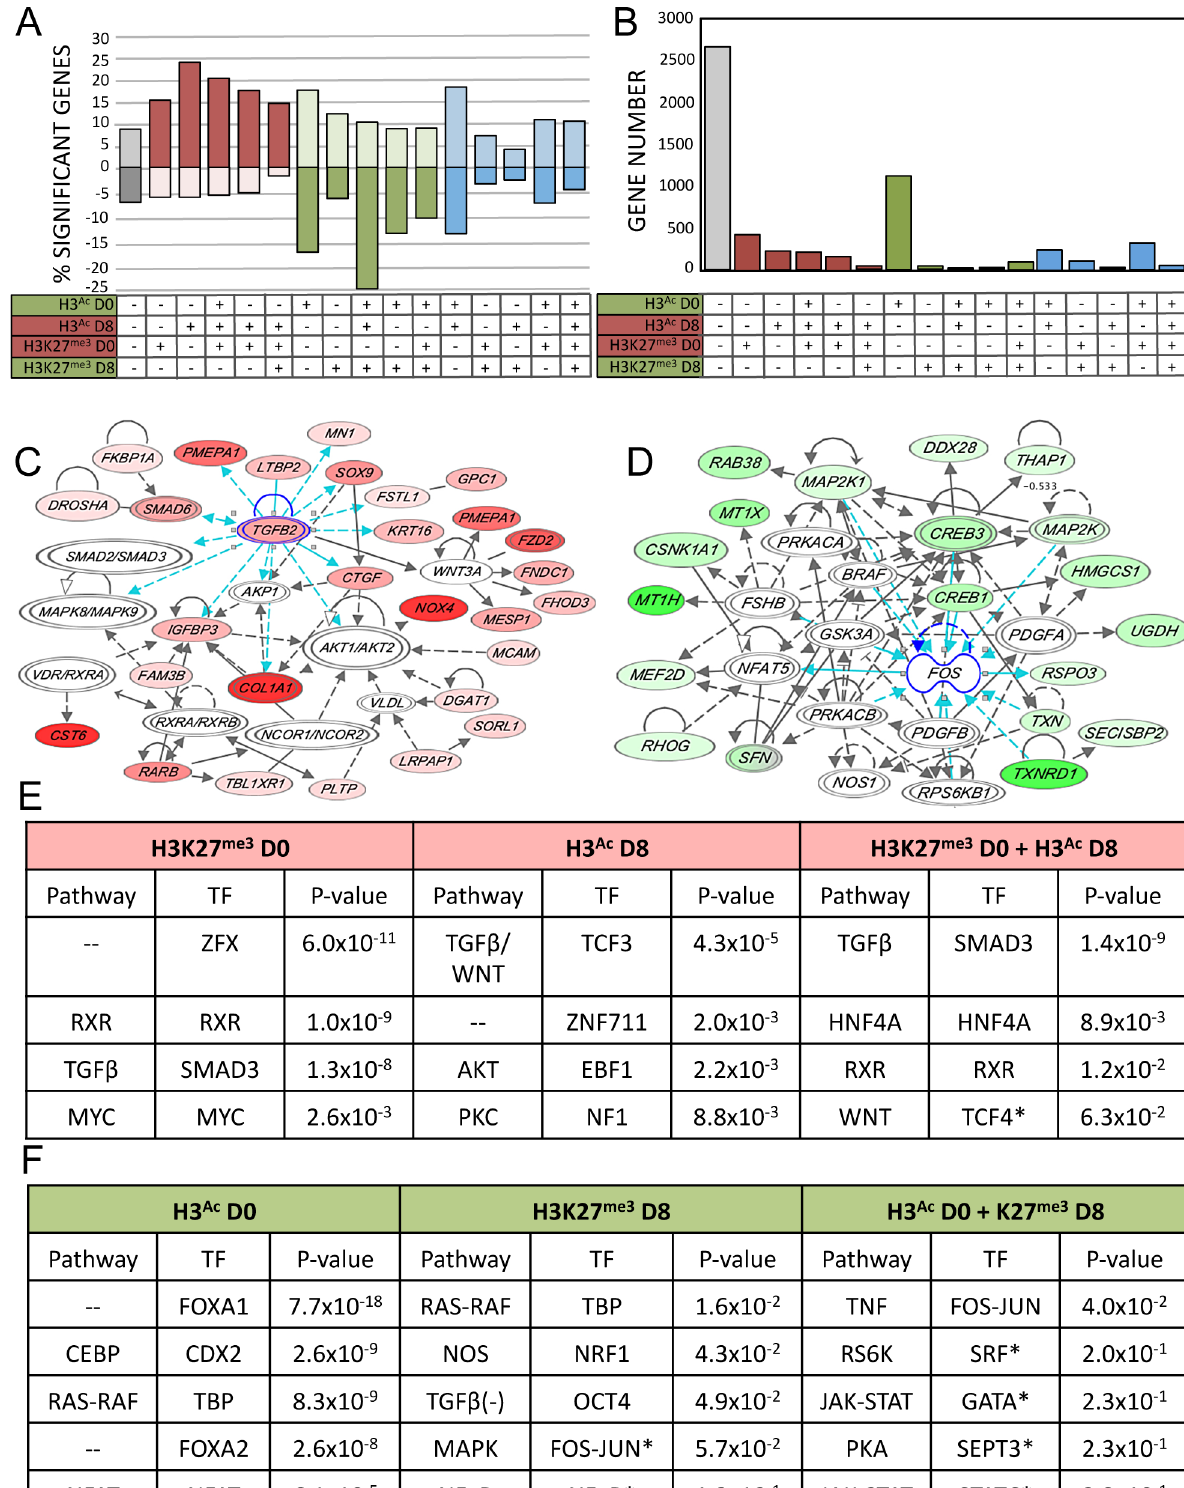
Figure 4. Integration of gene expression data with epigenetic alterations. A–B–C) Relationship between all 16 possible combinations of chromatin changes and gene expression. Grey=unassociated with H3K9/14 Ac or H3K27 me3 changes, red=potentially activating chromatin changes, green=potentially repressive chromatin changes, blue=mixture of both. A) Significant expression changes in genes as a percentage of all genes associated with each histone mark for each of the possible 16 combinations of chromatin marks. Upregulated=above x-axis, downregulated=below x-axis. B) Total number of genes with significant gene expression changes associated with each chromatin combination. C) Representative IPA